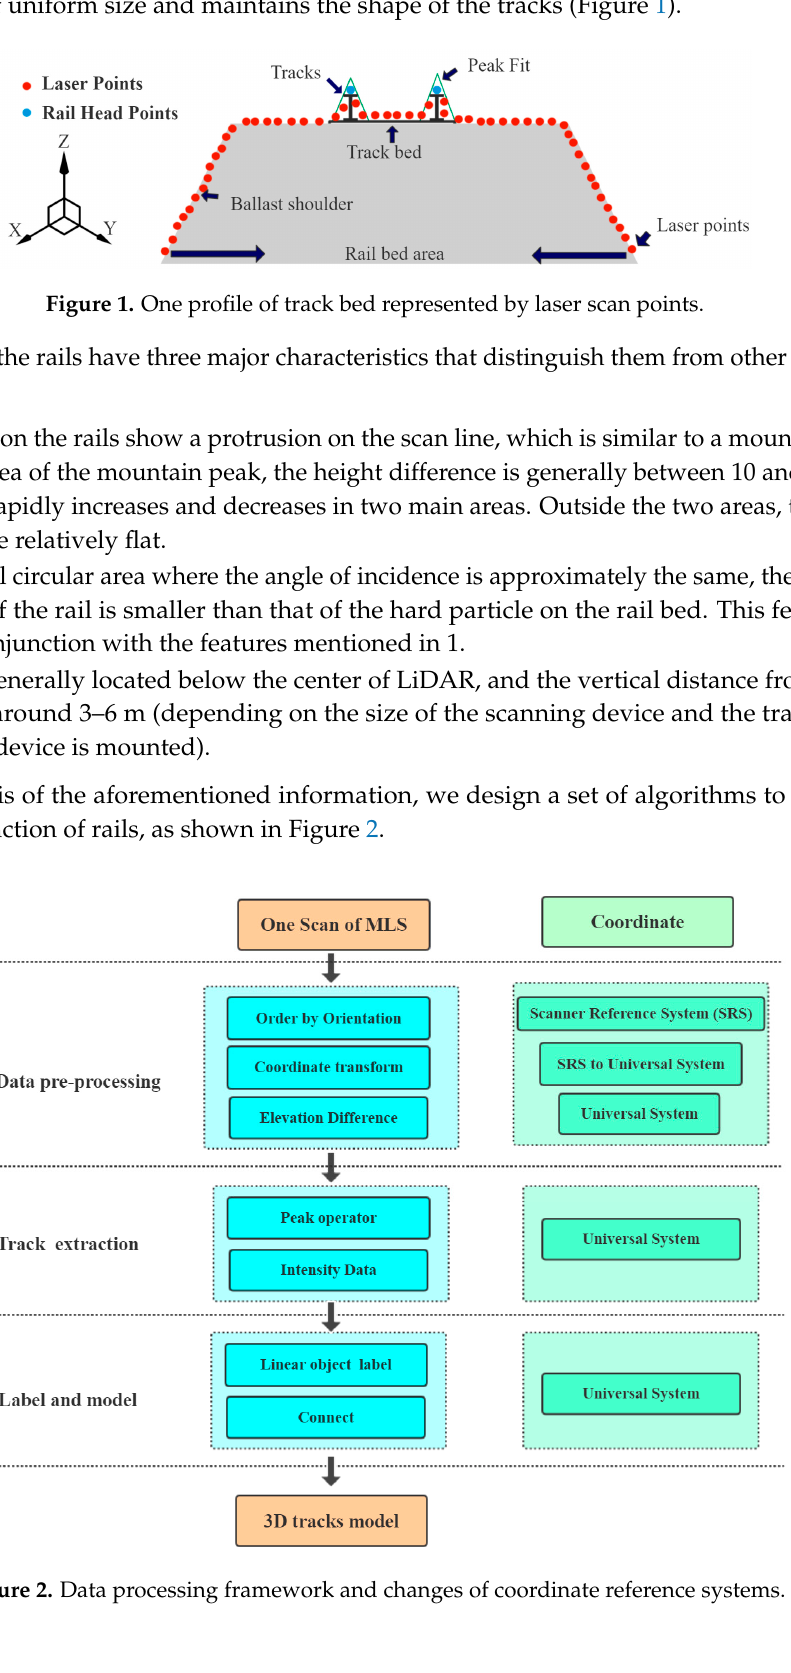
Figure 2. Data processing framework and changes of coordinate reference systems.